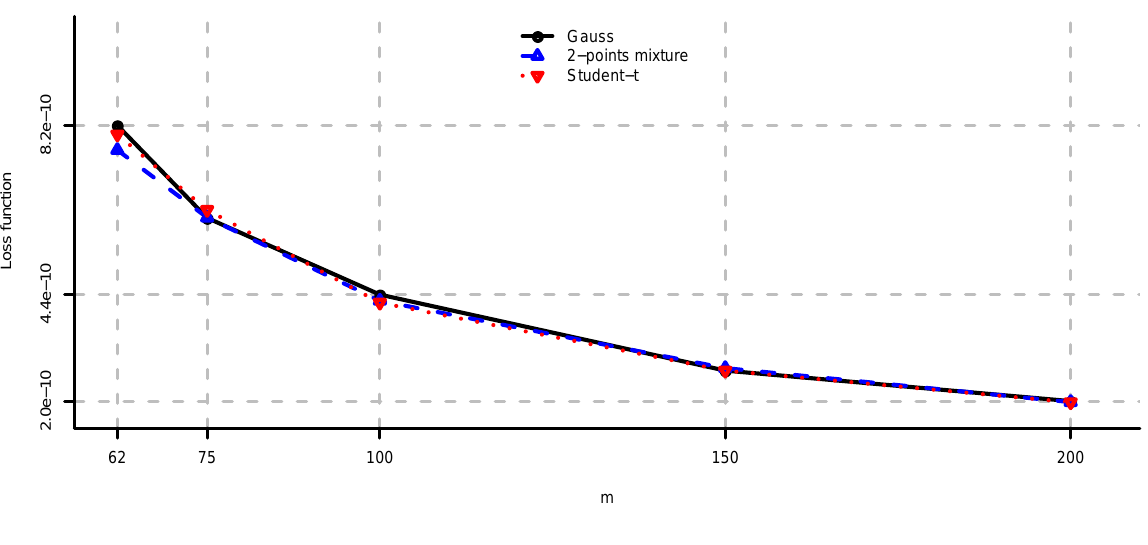
Figure 12. L ( U md , U md , A ) for N = 1000 and different values of m